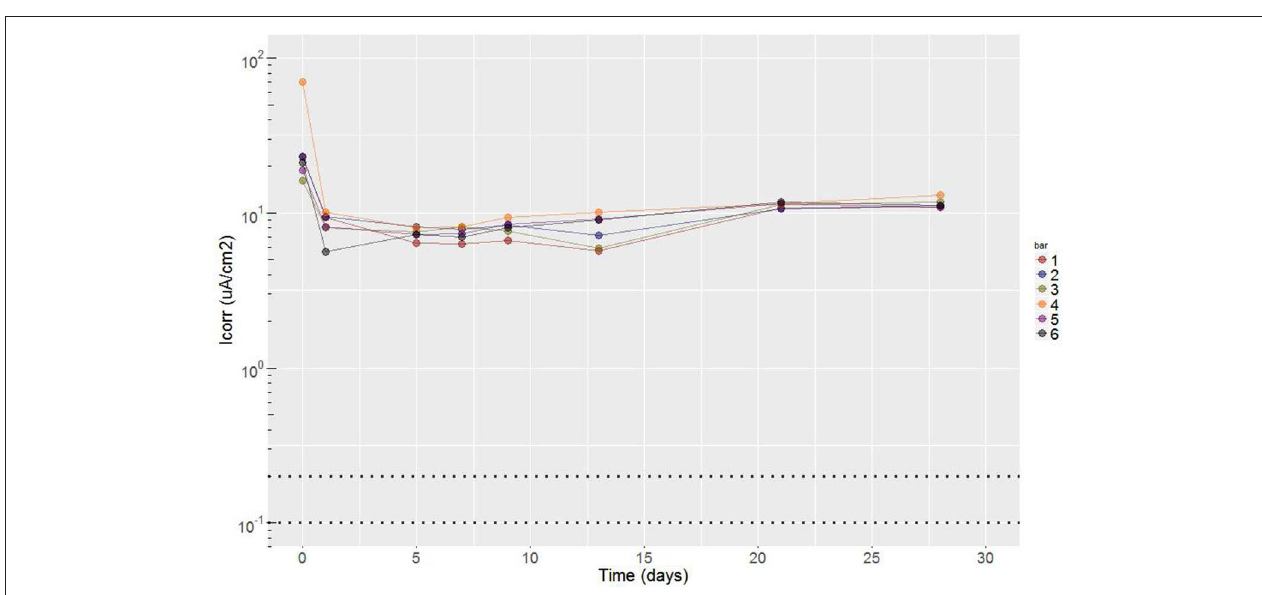
FIGURE 3 | Corrosion rate ( I corr ) over time in submerged steel